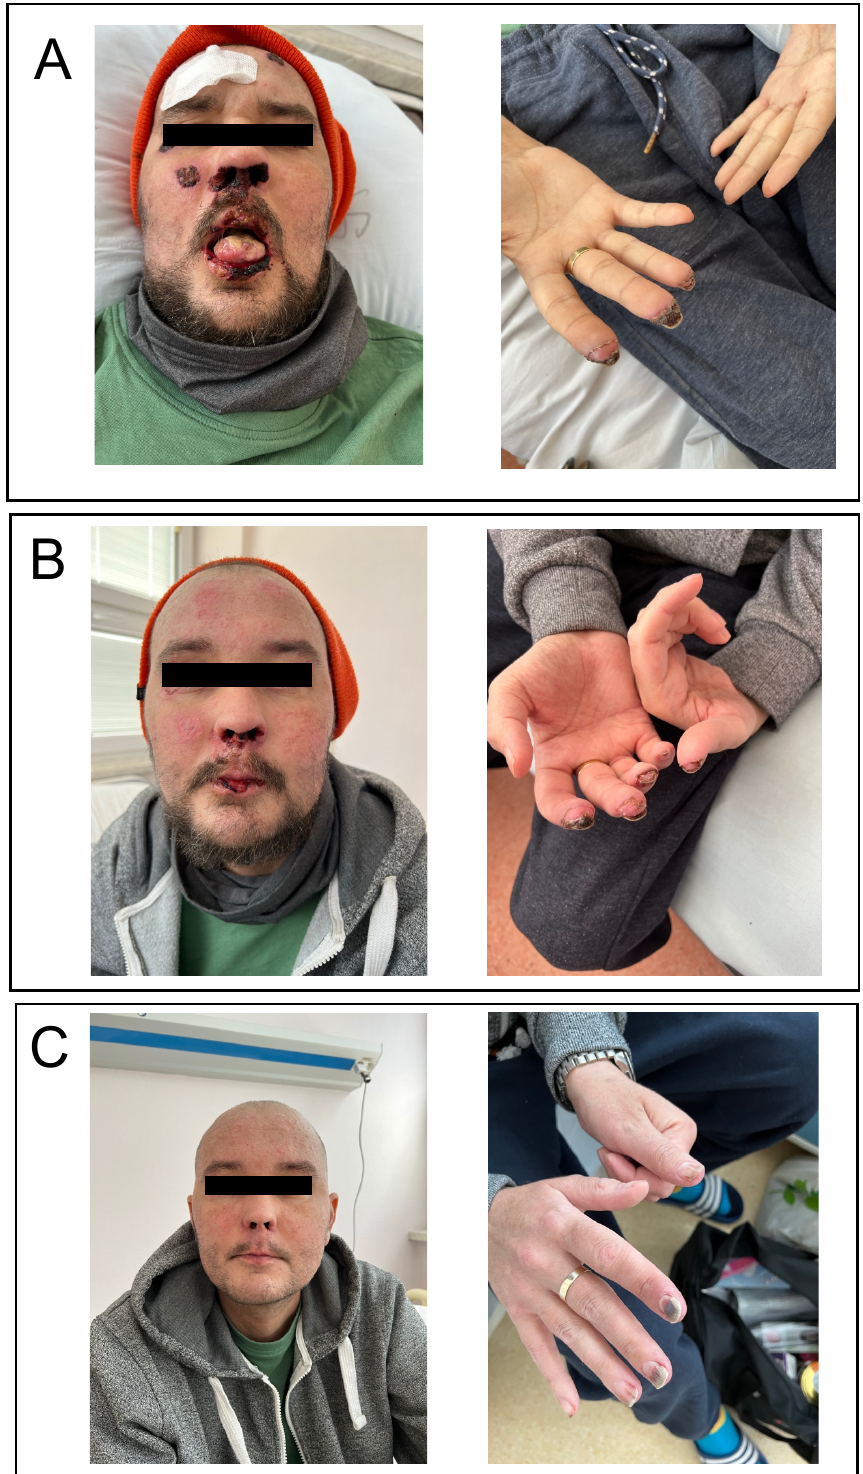
Figure 1. Favourable effects of therapy with extracorporeal photopheresis (ECP) to treat skin and mucosa advanced chronic graft-versus-host disease (cGVHD): ( A ) presentation of symptoms before treatment (+304 day post allo-HSCT); ( B ) partial regression after two ECP procedures (+310 day post allo-HSCT); and ( C ) almost complete response after four ECP procedures (+326 day post allo-HSCT).